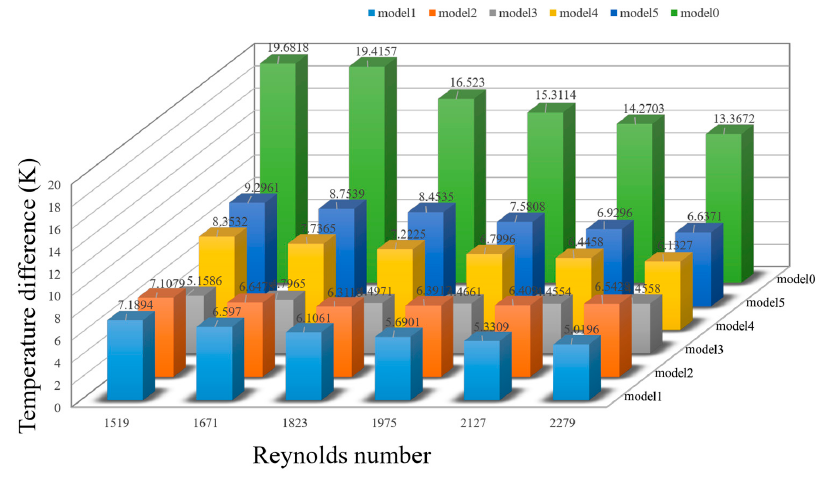
Figure 12. Effect of Reynolds number on temperature difference.